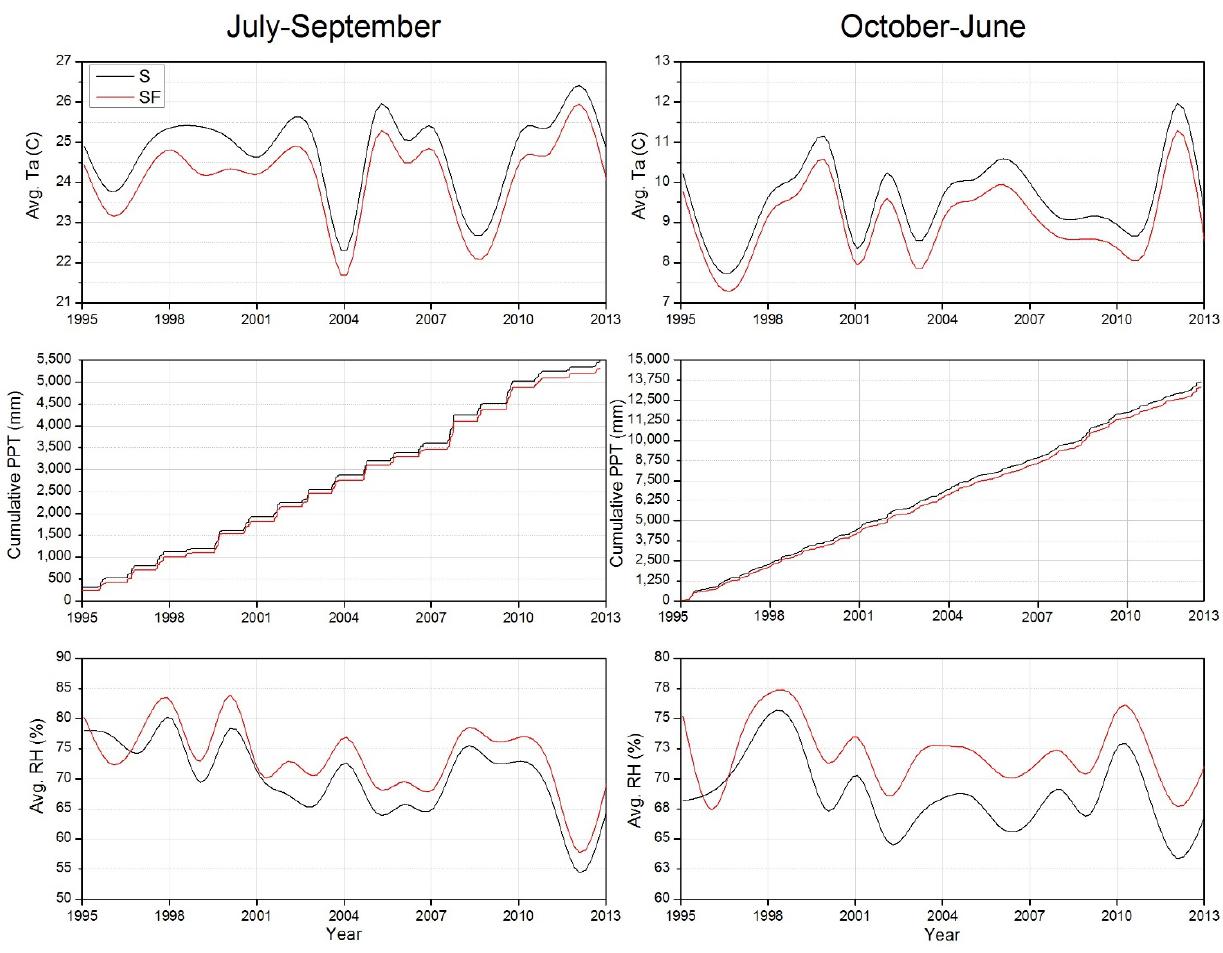
Figure 7. Climate time series during summer months (July–September) and fall through spring months (October–June), 18 January 1995–8 October 2013, Columbia, Missouri, USA. Ta = air temperature, PPT = precipitation, RH = relative